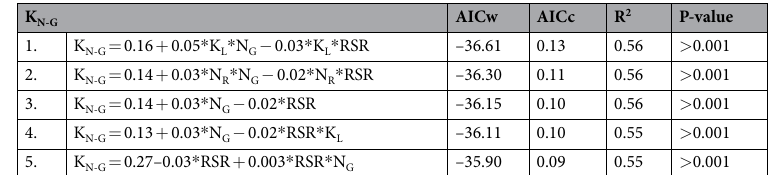
Table 2. The five candidate models explaining the nitrogen (N) distribution coefficient per ground surface area (K N-G ) as a function of light attenuation profiles (K L ), realised species richness (RSR), total leaf N (N G ) and the N content allocated to reproductive organs (N R ). No significant predictors were found for K N-F . AICc represents the Akaike Information Criterion adjusted for sample size whereas Akaike weights (AICw) represents the probability that a particular model is the best fit to the data. See Table 1 for an abbreviation list.